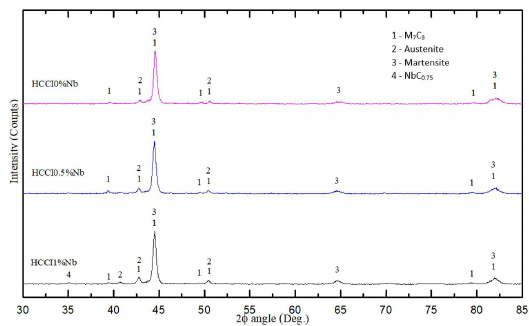
Figure 1. X-ray diffractometry performed on the samples.